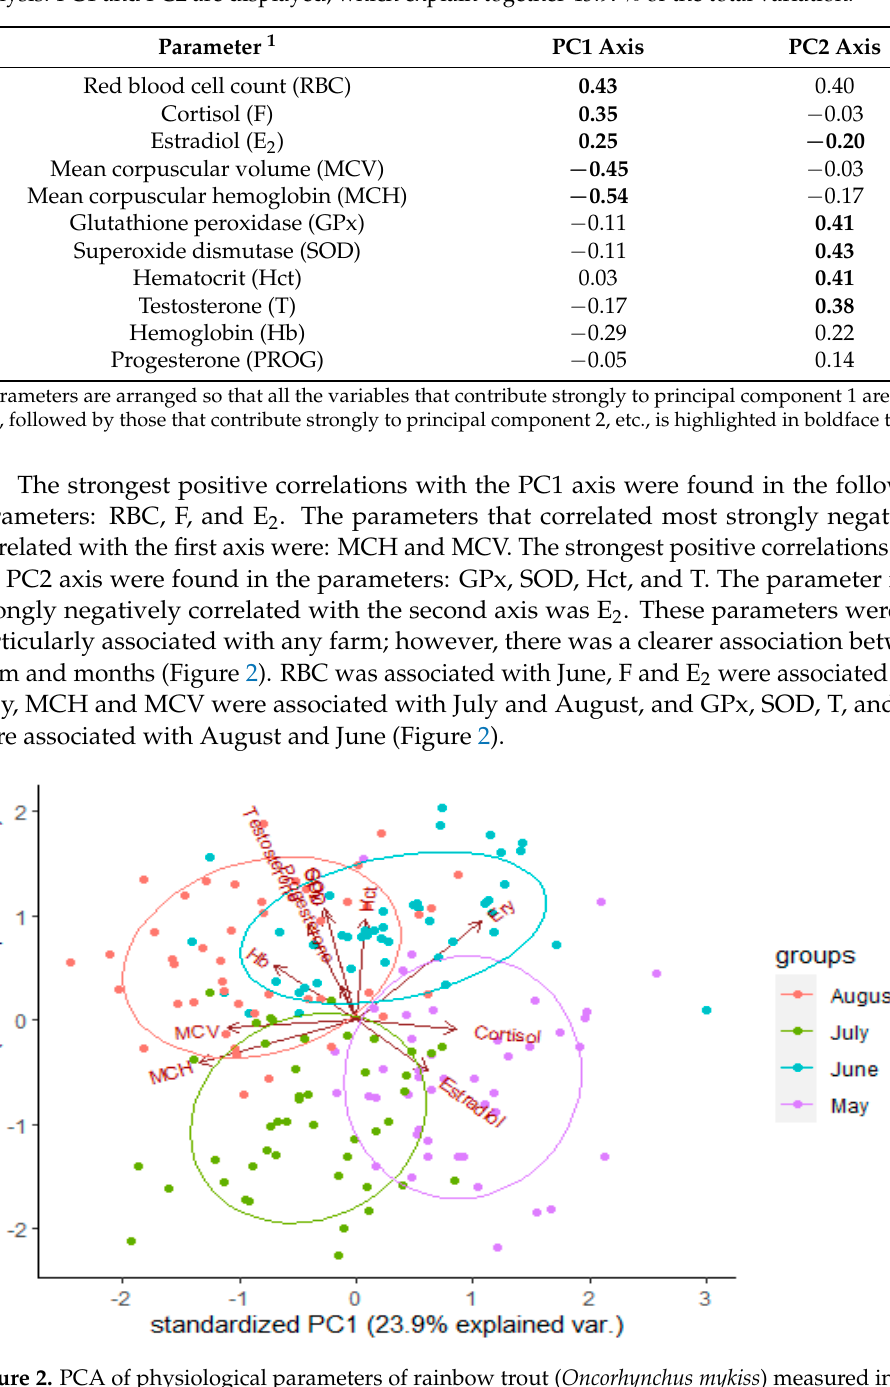
Table 2. Table of loadings for the physiological parameters investigated with a principal component analysis. PC1 and PC2 are displayed, which explain together 45.97% of the total variation.